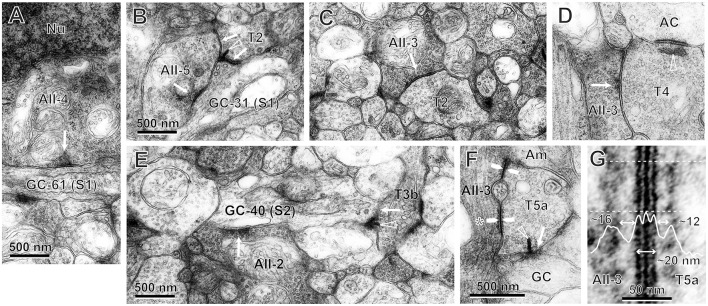
Electron micrographs of synaptic contacts (arrows) between bipolar cells of particular types (TNo.), AII amacrine cells (AII-cell number), and ganglion cells (GC-cell number) in stratum 1 (S1) or 2 (S2) of the IPL. Arrowhead: synaptic ribbon. (A) AII-4 has an output synapse to the dendrite of GC-61 in S1. (B) Both AII-5 and T2 cells have output synapses to the dendrites of GC-31 in S1. The T2 cell also has a ribbon synapse to the AII-5 cell. (C) The T2 cell has an input synapse from an AII amacrine cell. (D) The T4 cell has an input synapse from an AII amacrine cell, as well as a ribbon synapse to another amacrine cell. (E) Both AII-2 and T3b cells have output synapses to the dendrites of GC-40 in S2. (F) Gap junctions (pairs of arrows) between AII-3 and T5a cells. The T5a cell also has a ribbon synapse to a ganglion cell. (G) The magnified gap junction (asterisk of F) shows a striped pattern of three black lines with two intervening white lines. This gap junctional area is coated by fluffy subsurface material with spaces of different sizes on both sides in the cytoplasm. The density profile along the line perpendicular to the cell membranes is the average across the area between the two dotted lines.